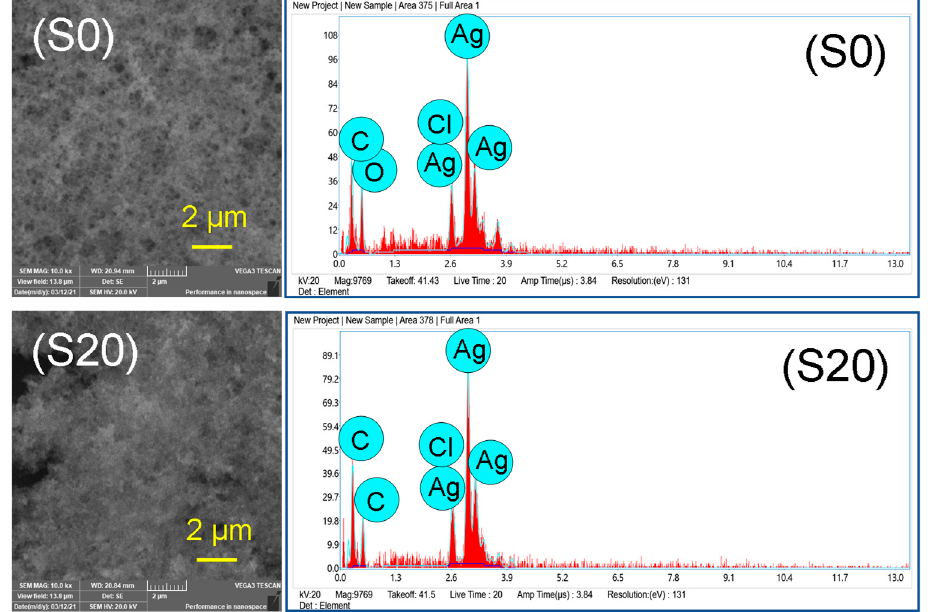
Figure 6. SEM images and EDX spectra of silver nanoparticles, S0 and S20.